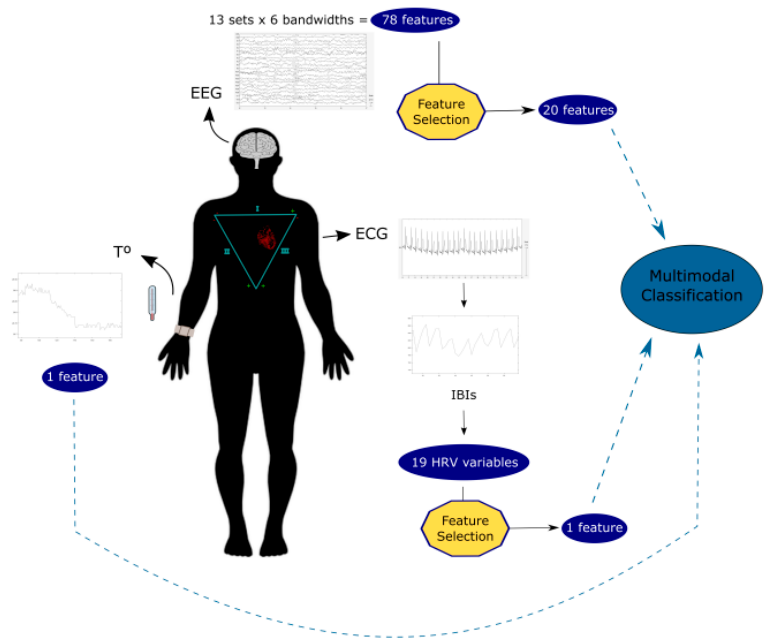
Figure 1. Experimental setup and multimodal approach for emotion classification. We performed the final multimodal classification stage with a total of 22 features (20 EEG frequency-location pairs, 1 HRV (heart rate variability) measure and skin temperature). Tº, skin temperature; IBIs, inter-beat intervals.